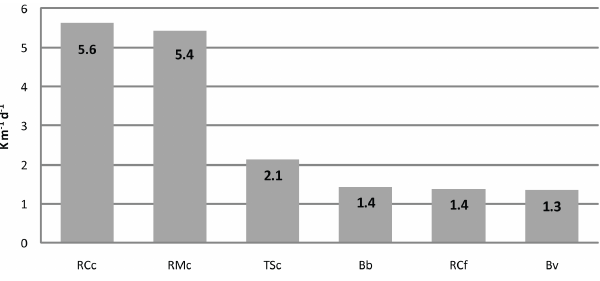
Fig. 11. Temperature transfer rate, calculated as 6-year mean from maximum summer borehole temperatures from 0.5m depth to the lower limit of the active layer in Km − 1 d − 1